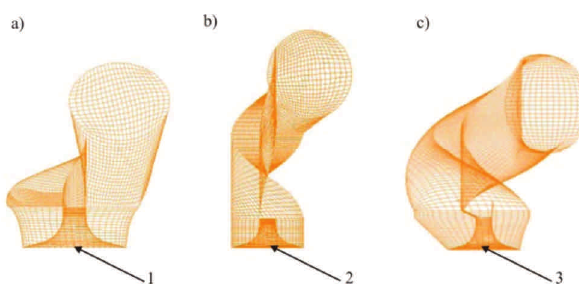
Fig. 5. The examples of discretion net of analysed type of intake channels [10]: a) – spiral type, b) – helical type, c) spirally-helical type, 1–3 – localisation of inlet valve heads